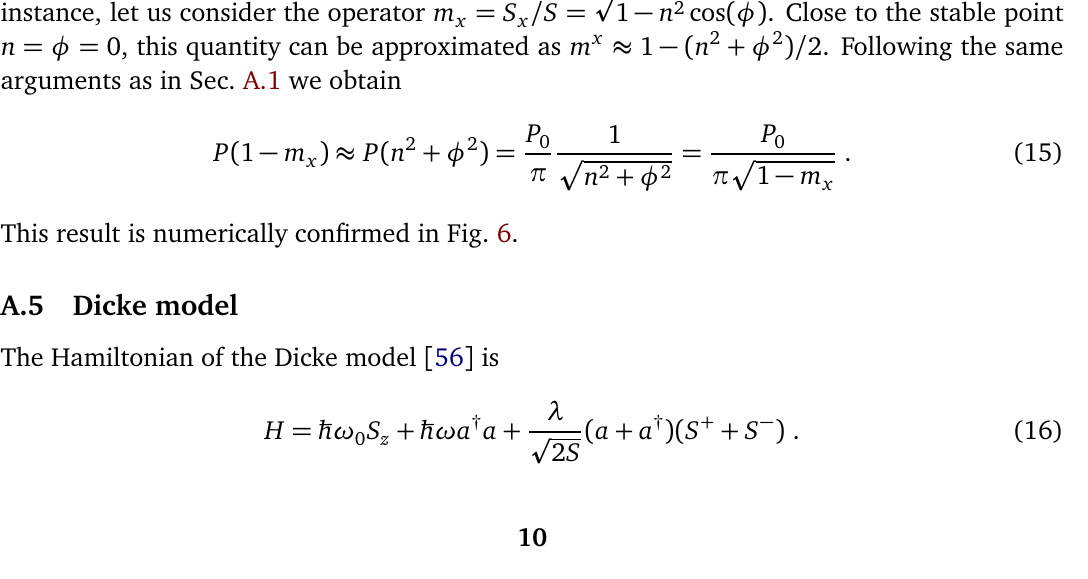
Figure 5: Steady-state distribution function of m Meshkov-Glick model, Eq. 4 with J /µ = 0.5 and different values of the total spin S. The constant of motion S plays the role of an IR cutoff for the scale invariant distribution